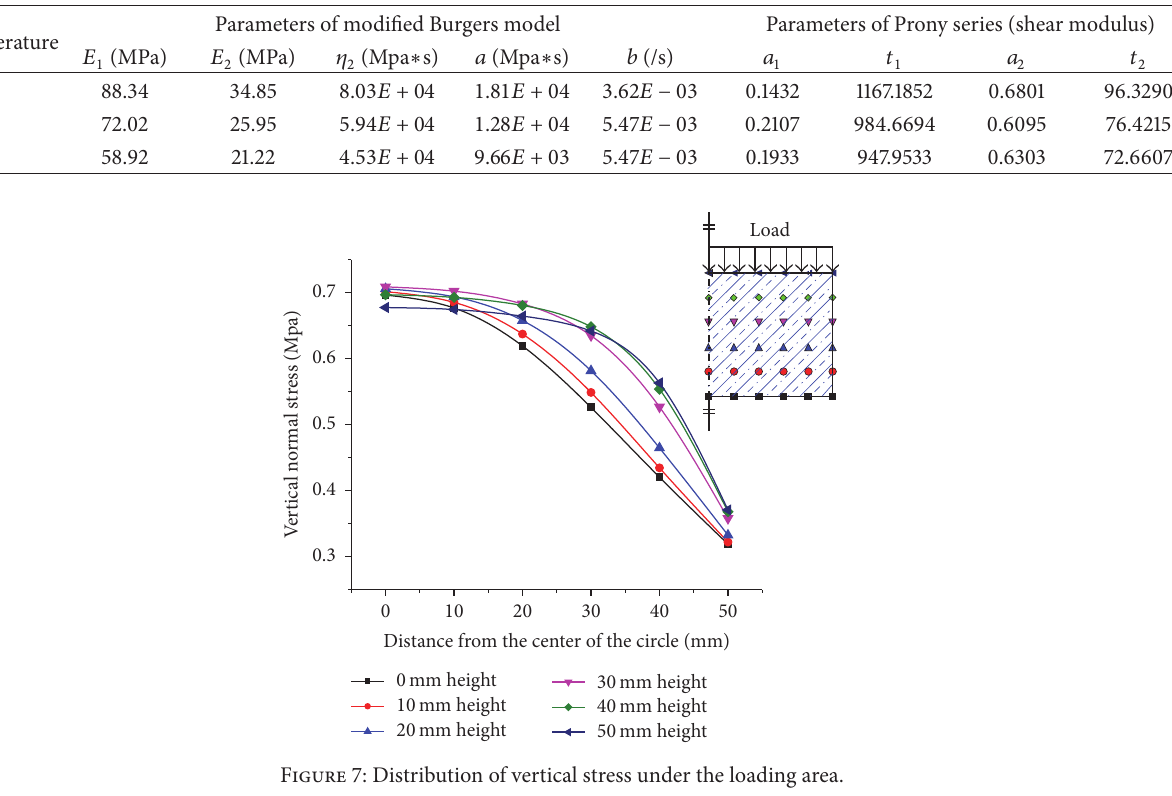
Table 4: Fitting results of experimental data.